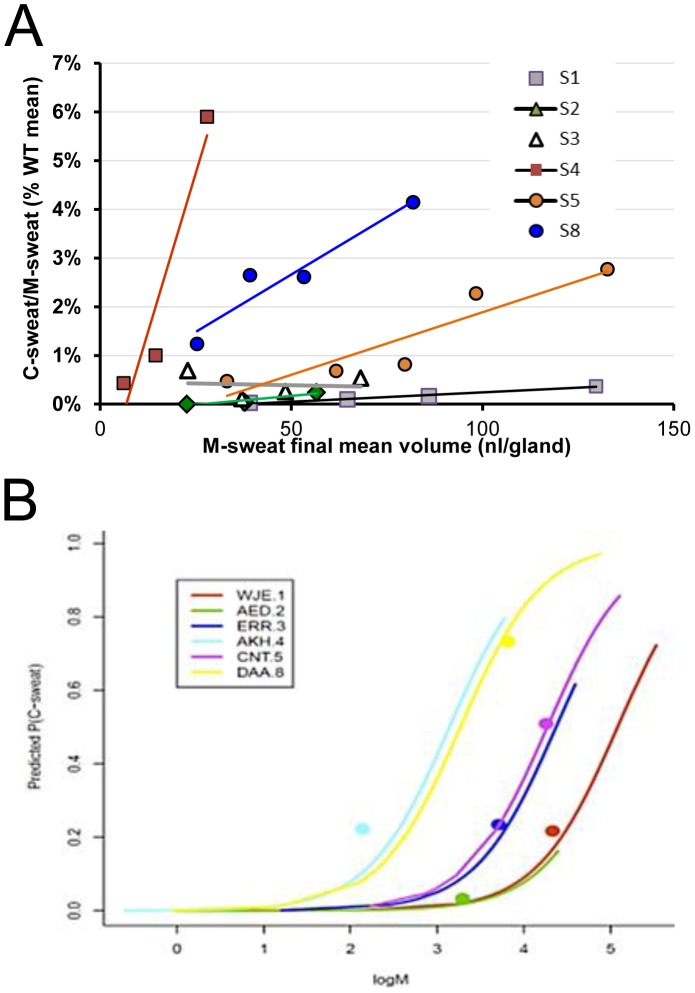
C-sweat values as a function of M-sweat rates.(A) Summary data showing dependence of C/M ratios to M-sweat rates for all 6 subjects tested (+) ivacaftor. For clarity, each subject's glands, glands were rank ordered according to their M-sweat rates and then divided into 3–5 bins according to their M-sweat rates (mean of 16.6 glands per bin). Each point plots the average M-sweat response on the x-axis and the average C/M ratio as a% of the WT mean on the y-axis for each bin; lines are linear fits. Each gland was measured 1–3 times, and the average number of glands included in each bin was 16.6 (range 5–26 glands). C/M vs. M-sweat correlations were significant for all subjects except S3. (B) C-sweat response is coded as 1, if some C-sweat is observed on a test, and 0, otherwise; and P(C-sweat) denotes the probability that C-sweat is observed. Then P(C-sweat) is also the average of the recoded 0/1 C-sweat response. We predicted P(C-sweat) as a function of log M-sweat using the combined data from all 6 CF subjects tested (+) ivacaftor. A logistic mixed model analysis showed that CF patients differed in their overall P(C-sweat) levels, but not in the within-patient effect of M-sweat response on P(C-sweat) across glands (p>.57), and that the average across patients of the within-patient effect of M-sweat was significantly positive (b = 2.14, p<.0001). The predicted P(C-sweat) levels are plotted for each patient. See methods and Appendix S1.